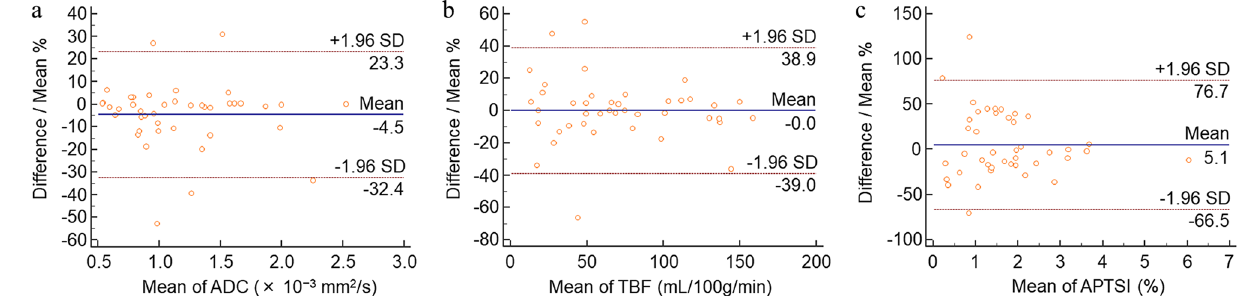
Figure 1. Bland–Altman plots of apparent diffusion coefficient (ADC) ( a ), tumor blood flow (TBF) ( b ), and amide proton transfer related signal intensity (APTSI) ( c ) assessing the interobserver agreement.